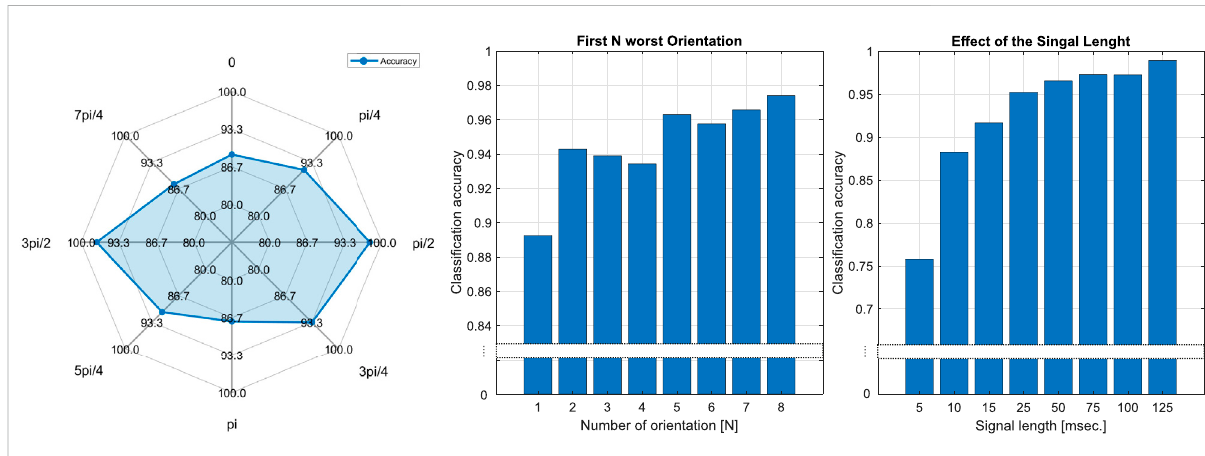
FIGURE 9 Damage classi fi cation results. Left, classi fi cation accuracy for different orientations of the gripper illustrated in Figure 6. Middle, the damage localization accuracy for combinations of N worst gripper orientations (ranked according to their classi fi cation accuracy). Right, the classi fi cation results with respect to the number of data points in the time